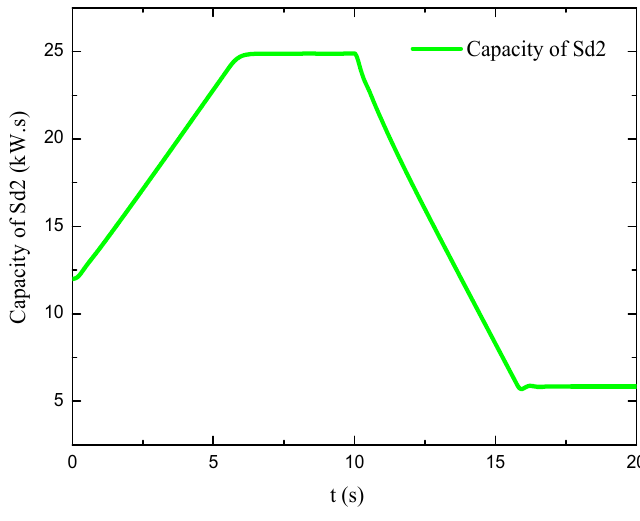
Figure 8. The capacity of Sd2.